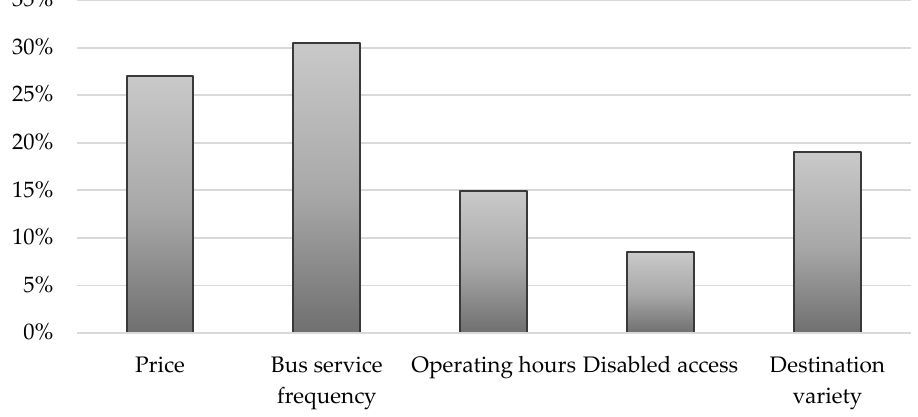
Figure 10. Rating conditions for park-and-ride facilities.